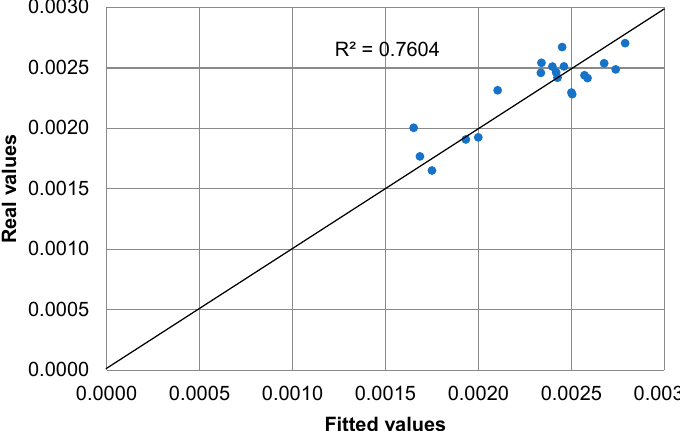
Figure 2. Real values versus estimated values for the four-factor model.